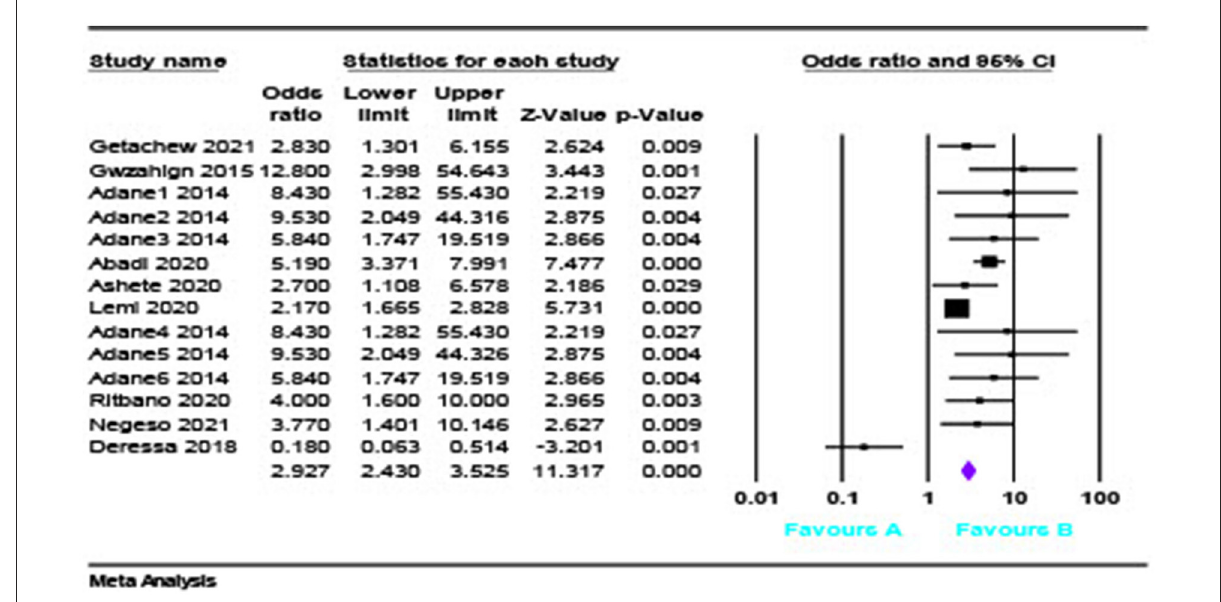
FIGURE3 Magnitude of adverse perinatal outcome following obstetrics emergency.